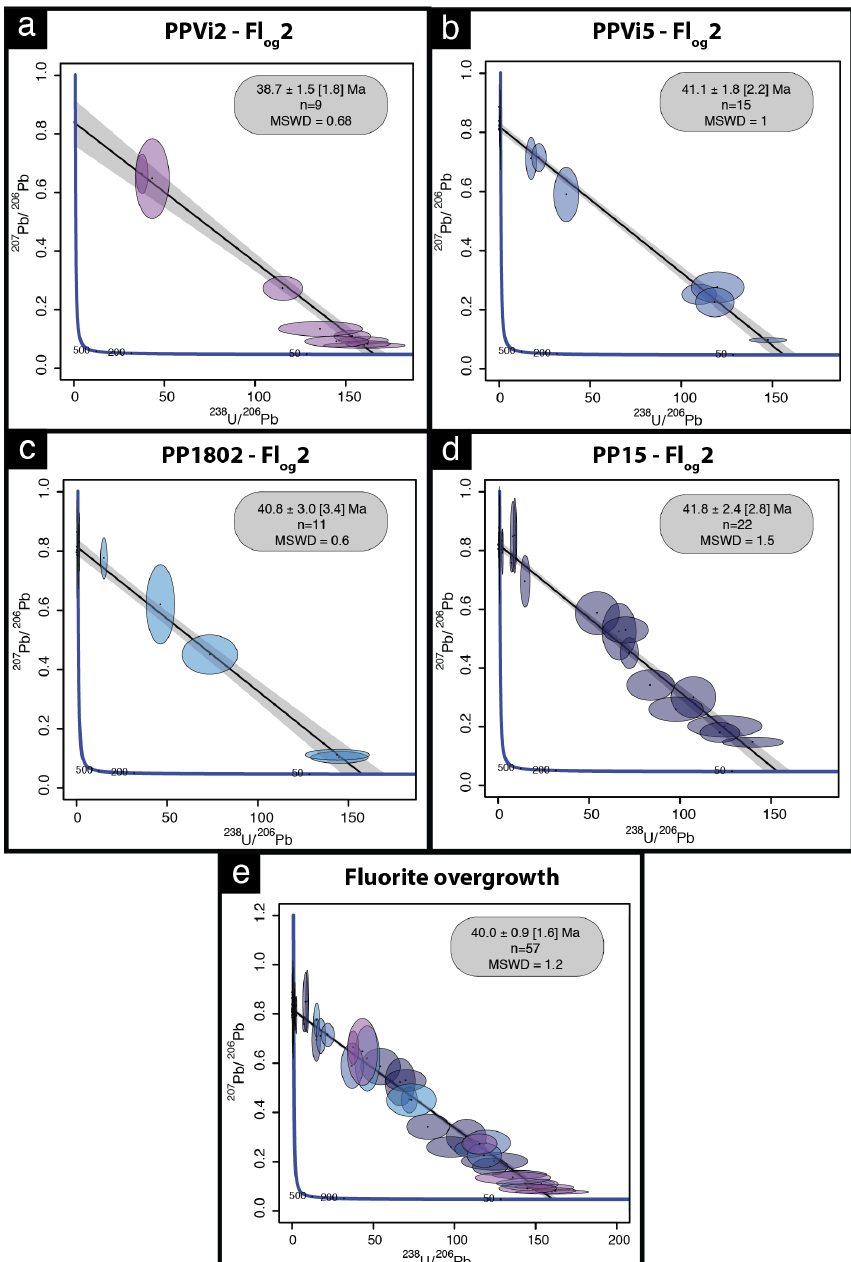
Figure 8. Tera–Wasserburg diagram of LA-ICP-MS data for fluorite. (a–d) U–Pb ages of the four fluorite overgrowth (Fl og 2) samples. (e) Isochron obtained from the compilation of all data illustrated in panels (a) – (d) ; n is the number of analytical spots for each sample.